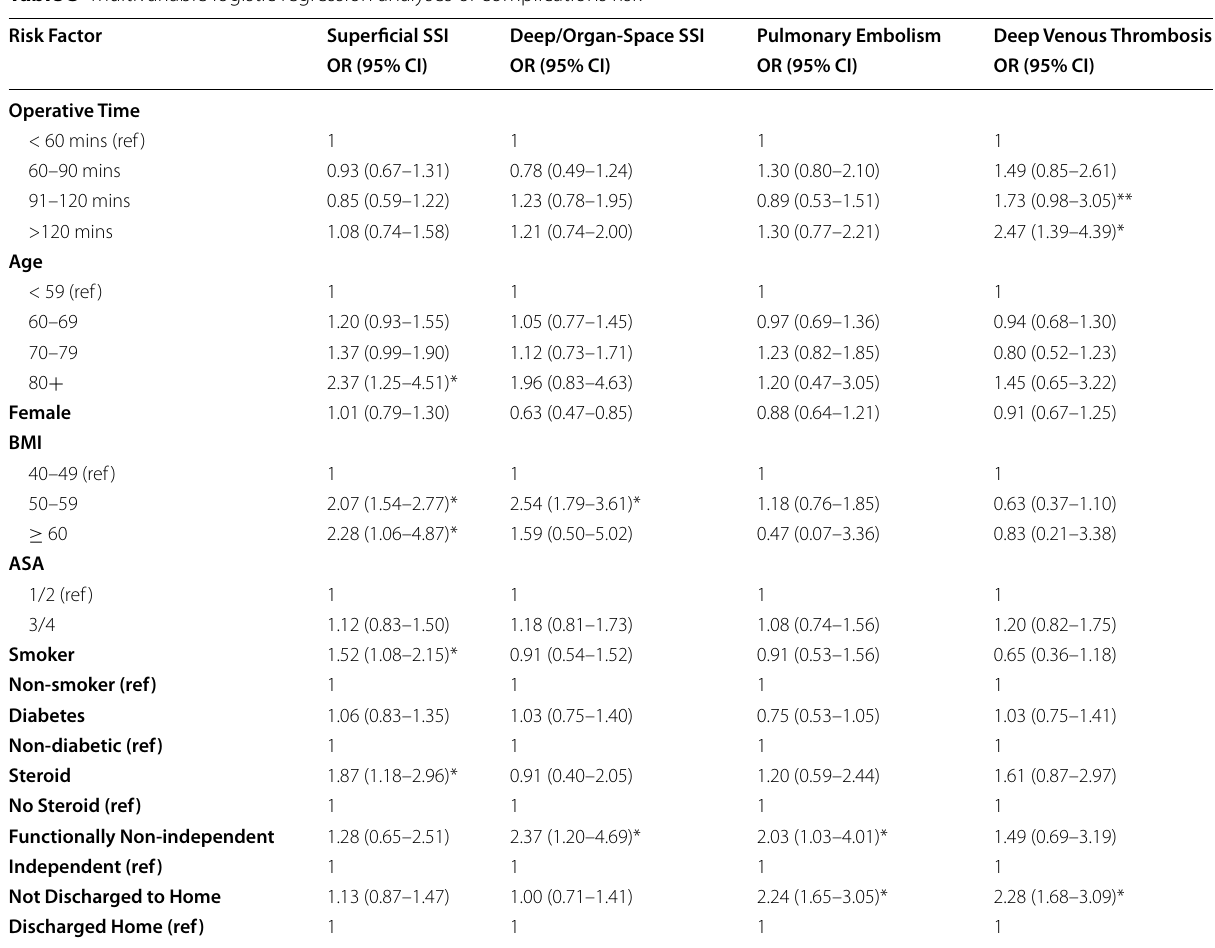
Table 3 Multivariable logistic regression analyses of complications